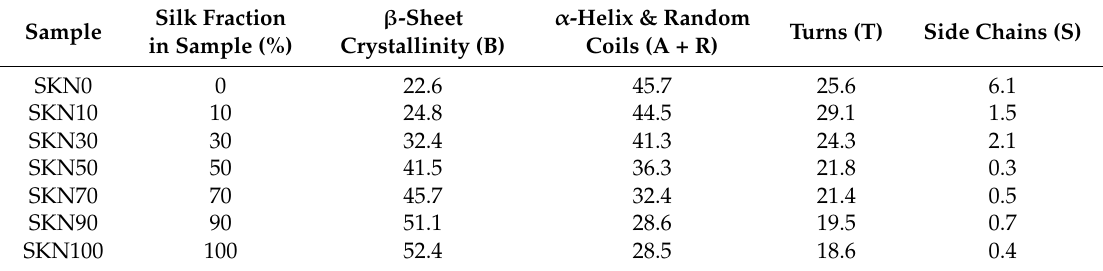
Table 2. Percentage of secondary structures in naturally self-assembled silk fibroin/keratin blends (all calculated secondary structure fractions have a same unit ( wt %) with a ± 2 wt % error